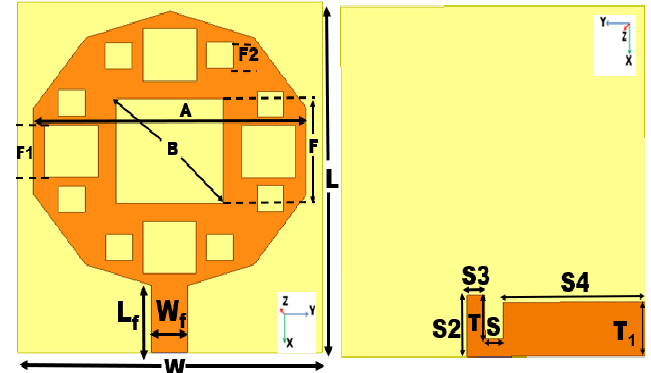
Figure 3. Antenna geometry for ultrawideband.